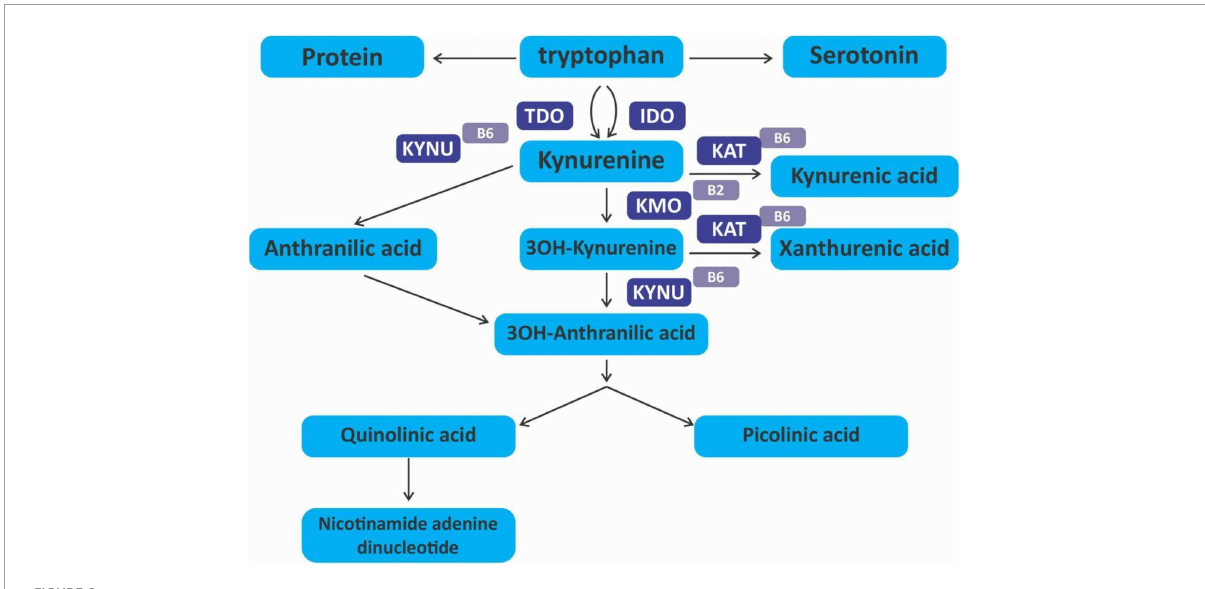
FIGURE6 Kynurenine pathway.